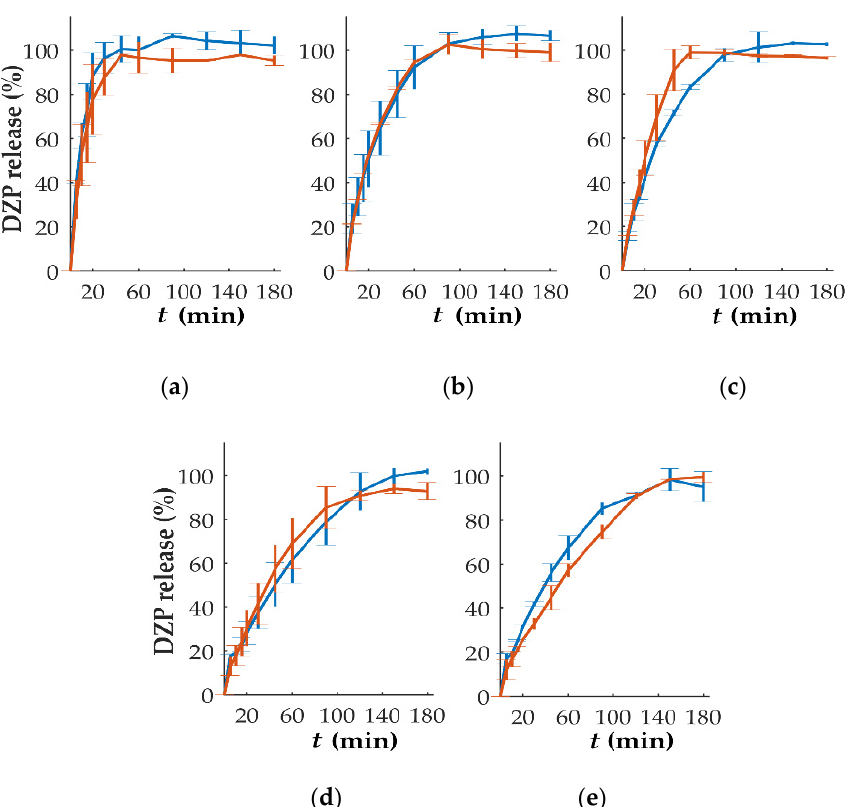
Figure 8. In vitro release (mean ± sd, n = 6) of diazepam (DZP) from printed tablets immediately after production (blue) and after 1 month of storage at 40 °C/75% RH (orange), with a dose of ( a ) 1, ( b ) 2, ( c ) 5, ( d ) 7.5 and ( e ) 10 mg.